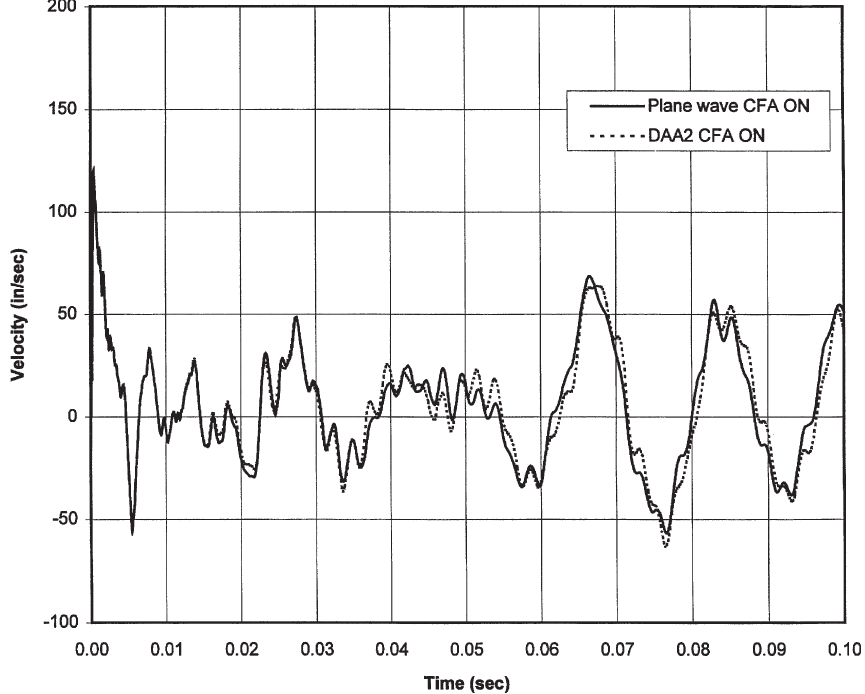
Fig. 10(c). Velocity response at the keel (node 42) for two cases: plane wave/CFA-on and